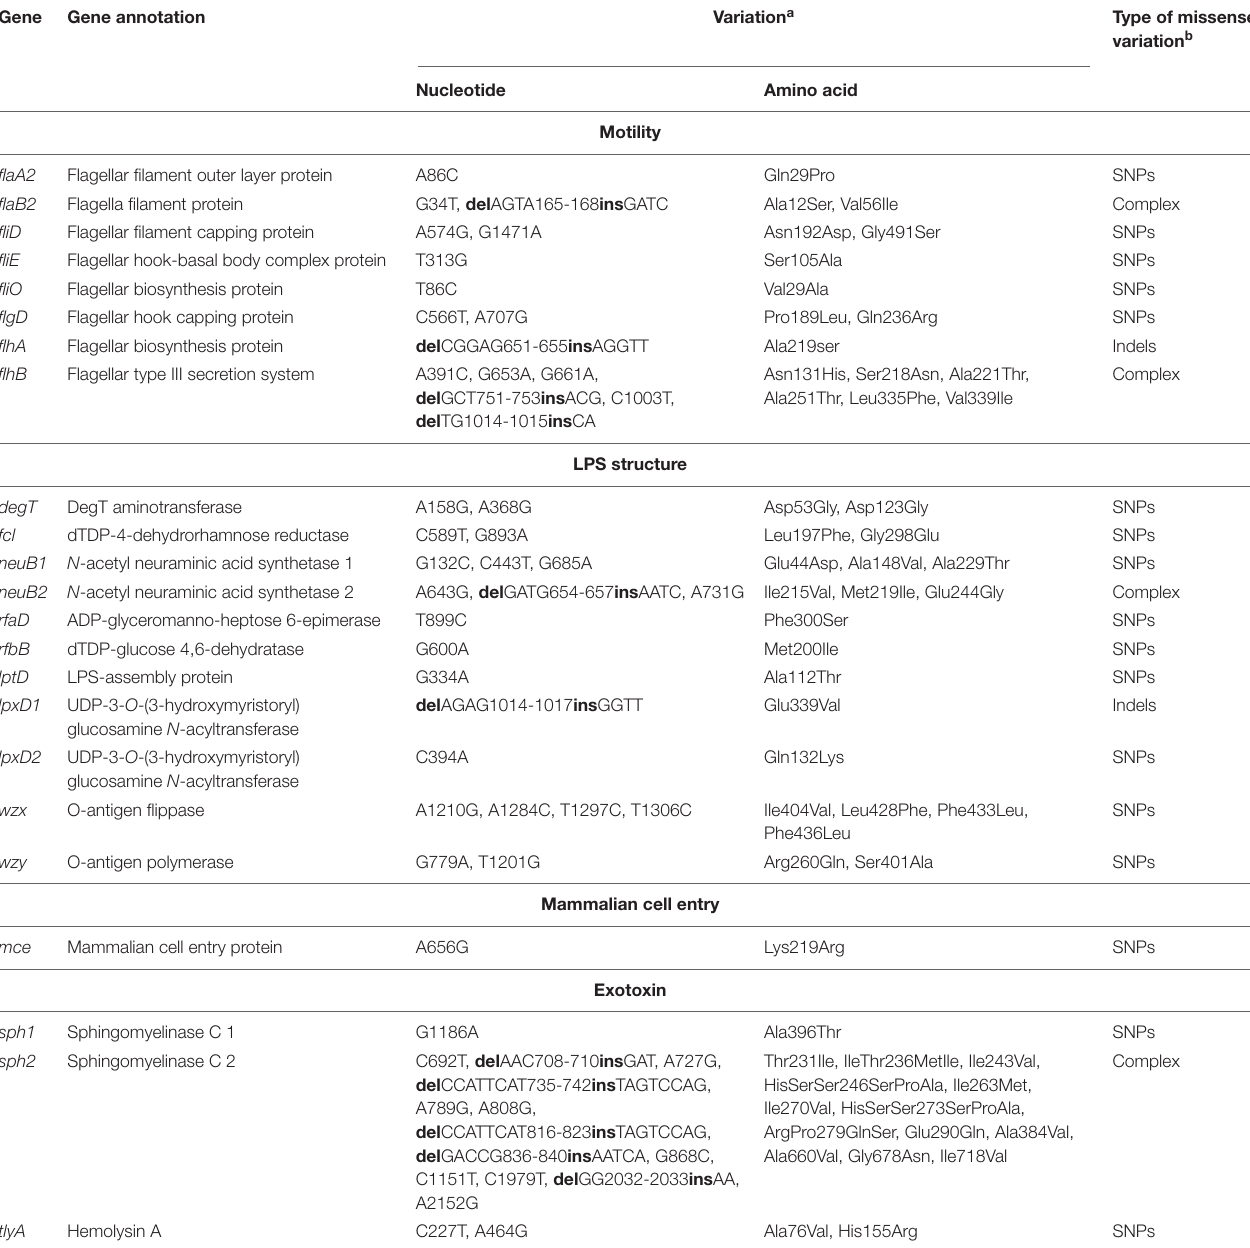
TABLE 2 | Genetic variation in 23 representative pathogenesis-related genes in L. weilii strains CUDO6 and CUD13 comparing to L. weilii strain 2006001853 as a